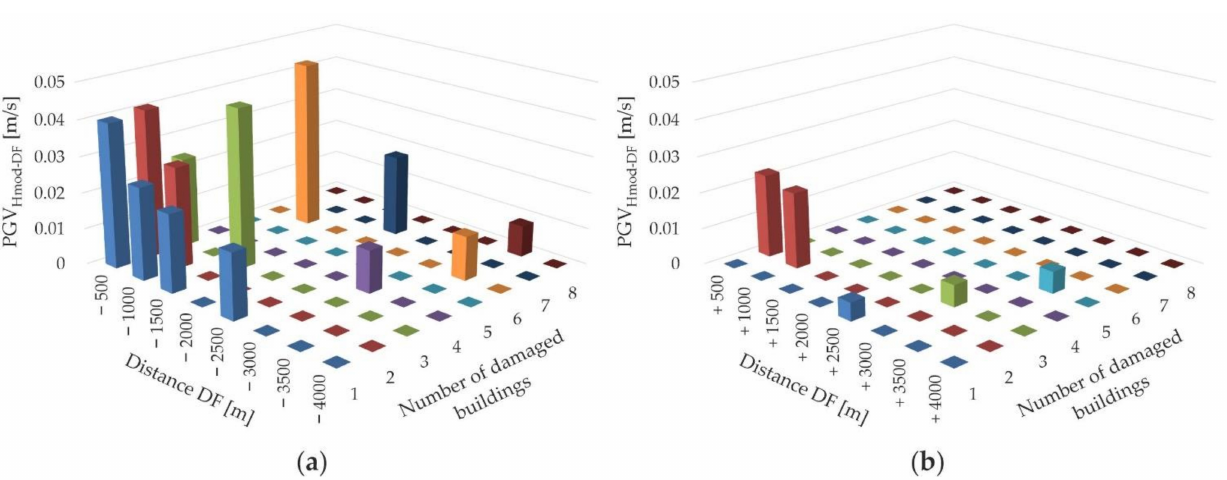
Figure 9. Distribution of PGV Hmod-DF at the site of the damaged building in terms of the distance DF from the hanging wall of the Barbara fault and number of damaged buildings from ( a ) south of the fault and ( b ) north of the